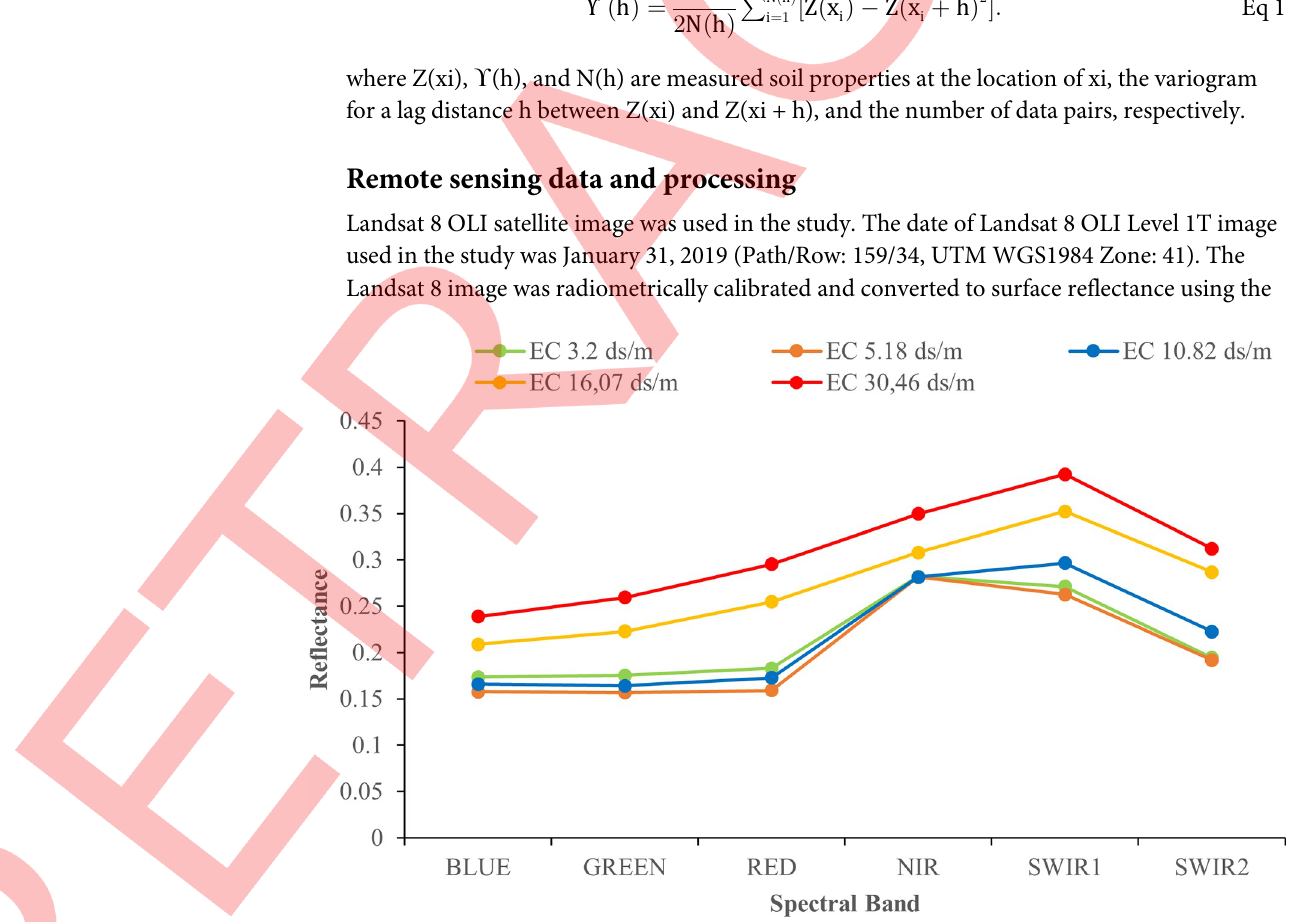
Fig 1. Landsat 8 OLI reflectance spectra curves of different soil electrical conductivity values in the study area.